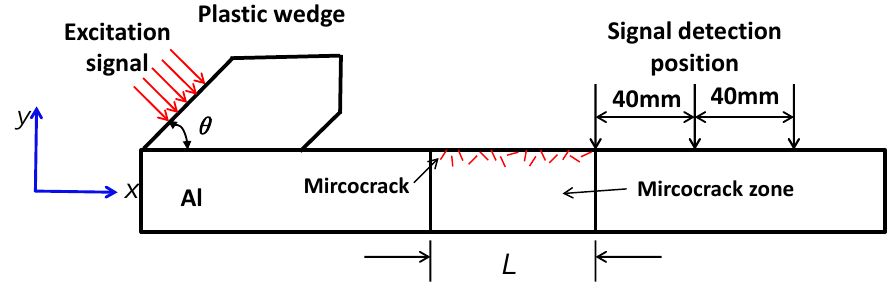
Figure 1. Schematic of Rayleigh surface waves propagating through a region with micro-cracks. To investigate the influence of micro-cracks on the acoustic nonlinearity parameter, N micro- cracks are randomly distributed at or near the surface of the middle part with length L . Note that when micro-cracks are near the surface, the distances from the surface to the centers of micro-cracks are less than the wavelength of the Rayleigh wave. The parameter w % is defined as the ratio of the number of surface micro-cracks divided by the total number of micro-cracks, which represents the proportion of micro-cracks on the surface. Thus, % = 100% means that all the micro-cracks are on the surface. Additionally, all the cracks have the same length of 2 a (the range of a is from 25 µm to 75 𝑤𝑤 µm in this study). Therefore, the crack density can be defined as c = Na/L , where c is a dimensionless parameter. In this study, there are two variables that affect the random distribution of micro-cracks, i.e., the center position and the orientation of cracks, which are described by the probability density function (PDF) with a uniform random variable in the simulations.